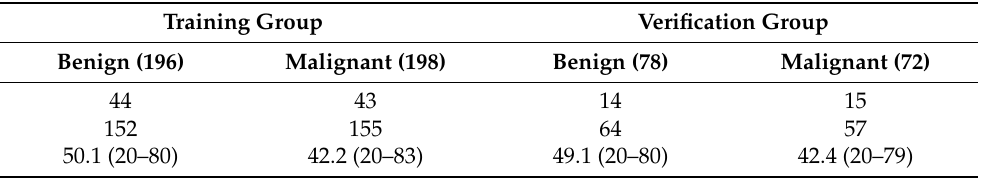
Table 1. The characteristics of the 394 patients included in the